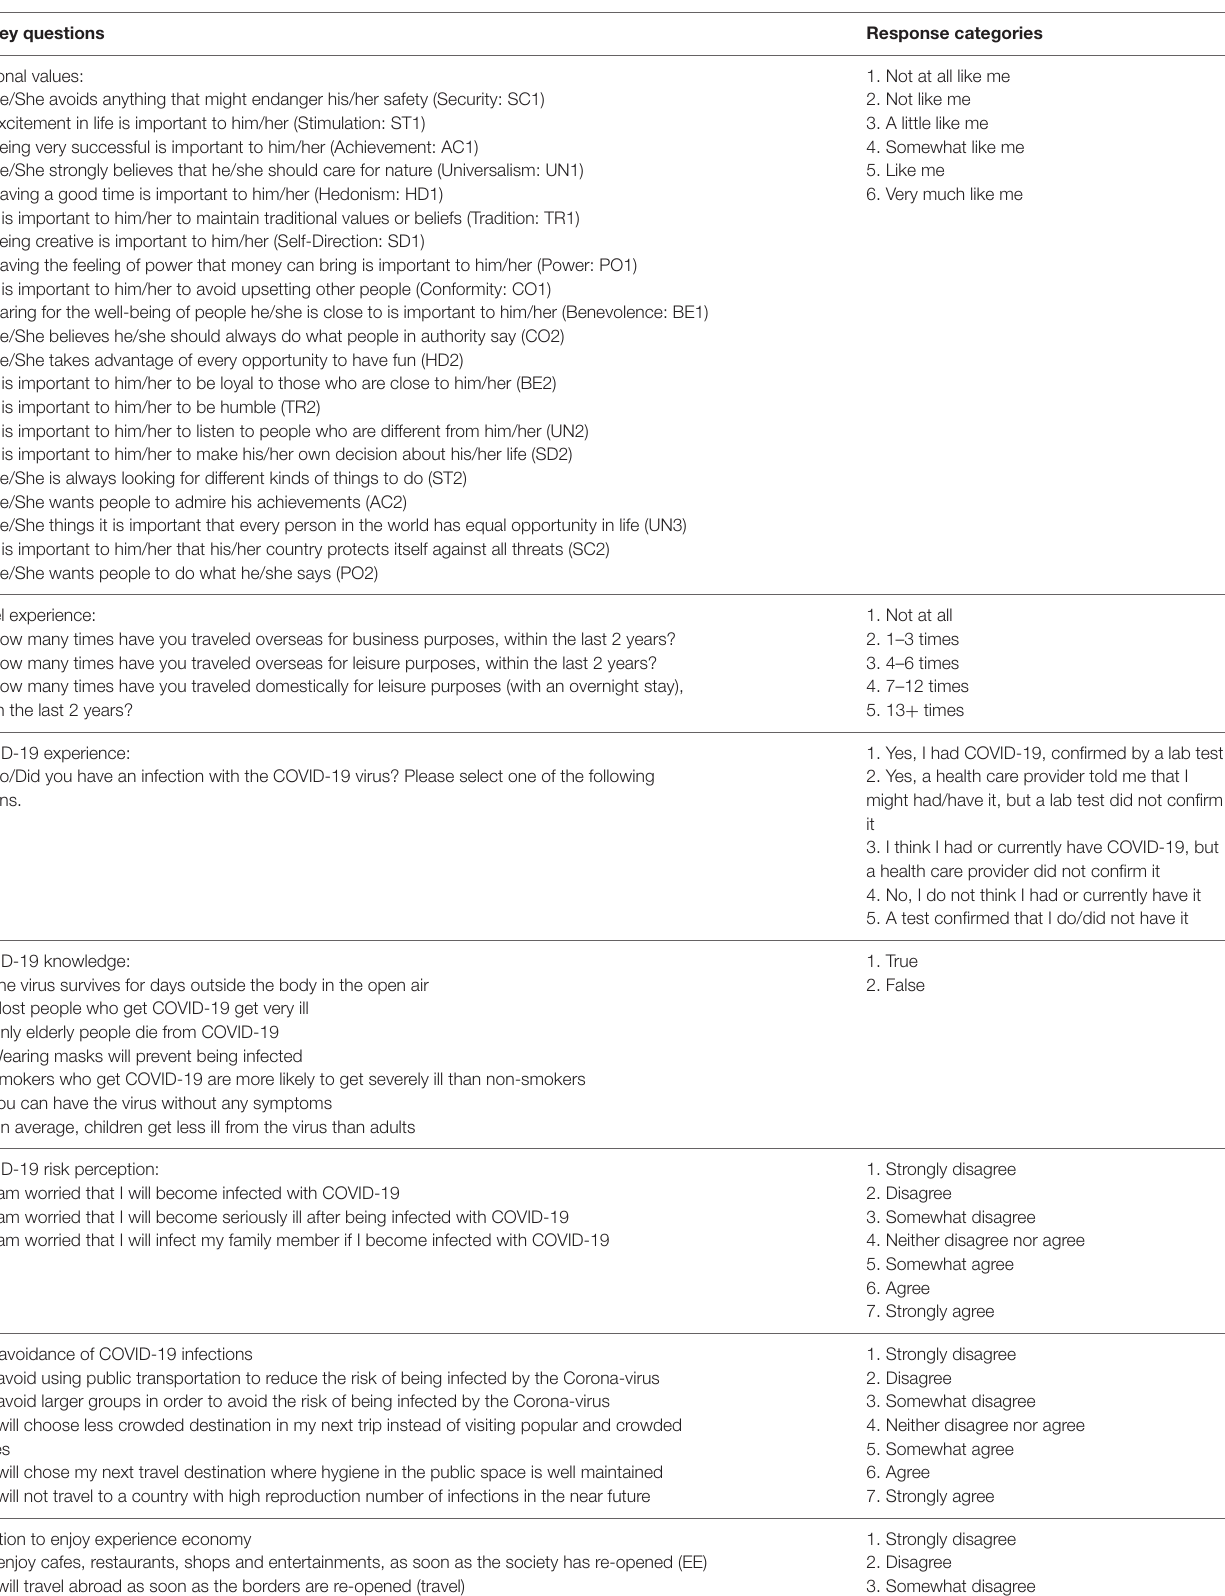
TABLE 1 | Survey questions and response